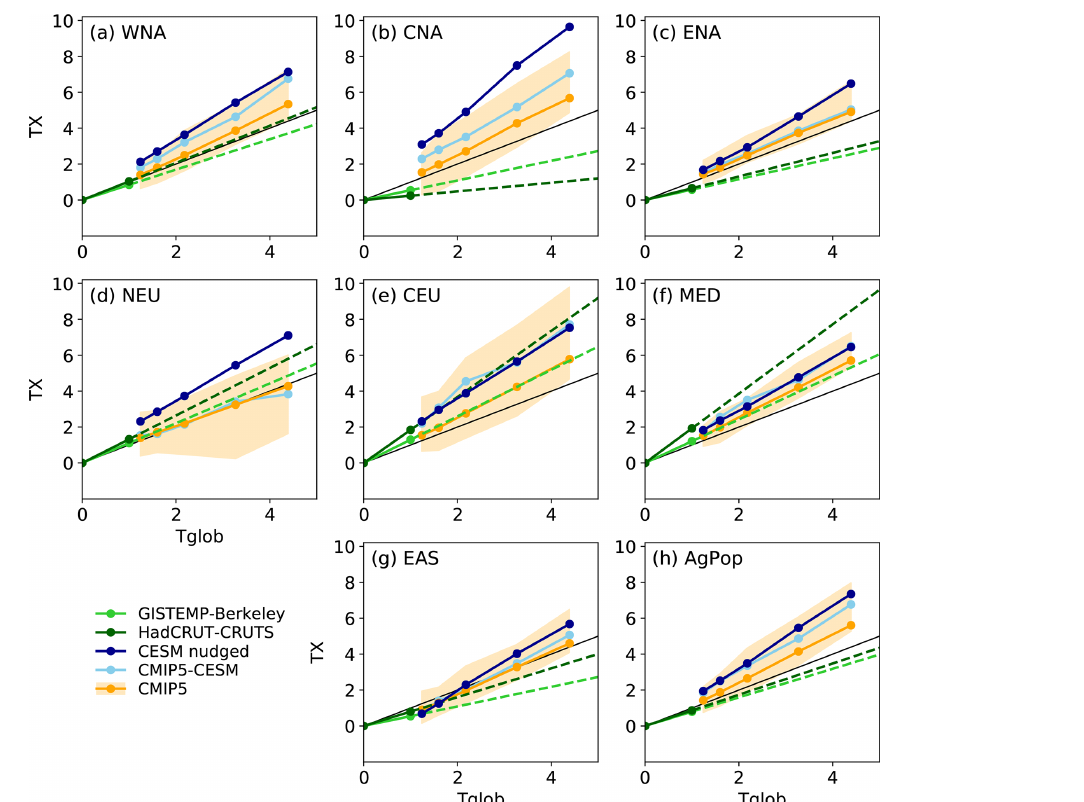
Figure 7. Scaling of daily maximum temperature (TX) for the study regions with global mean warming (Tglob). Shown is the mean TX for 13–27 July from the nudged CESM simulations (dark blue), the July mean TX for the CMIP5 multi-model mean (orange line) and the full model range (orange shading) as well as the July mean TX for CESM from the CMIP5 ensemble (CMIP5-CESM, light blue). The solid green lines correspond to the observed warming while the dashed green lines indicate the extrapolation beyond the observed warming (light green for Berkeley Earth using GISTEMPv4 as a reference for global mean temperature change and dark green for CRU TSv4.03 using global mean temperature anomalies from HadCRUT4). The black line indicates the 1 : 1